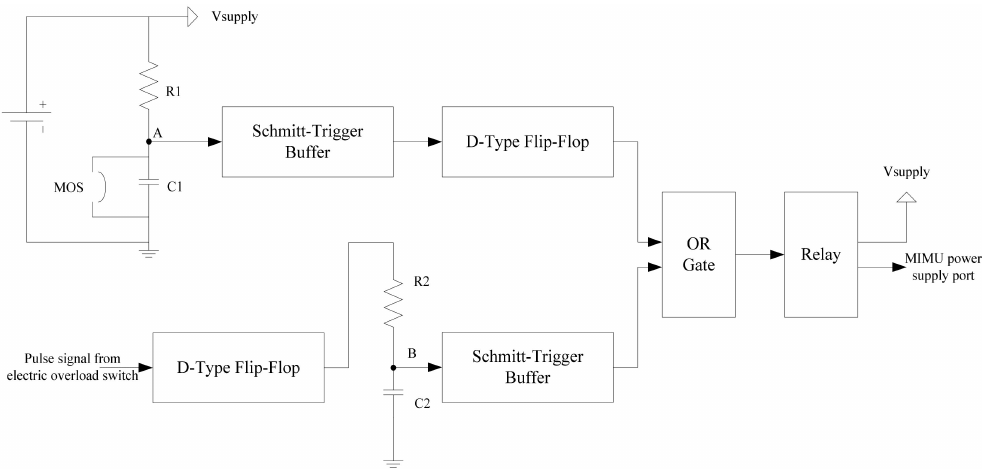
Figure 4. Schematic diagram of signal conditioning